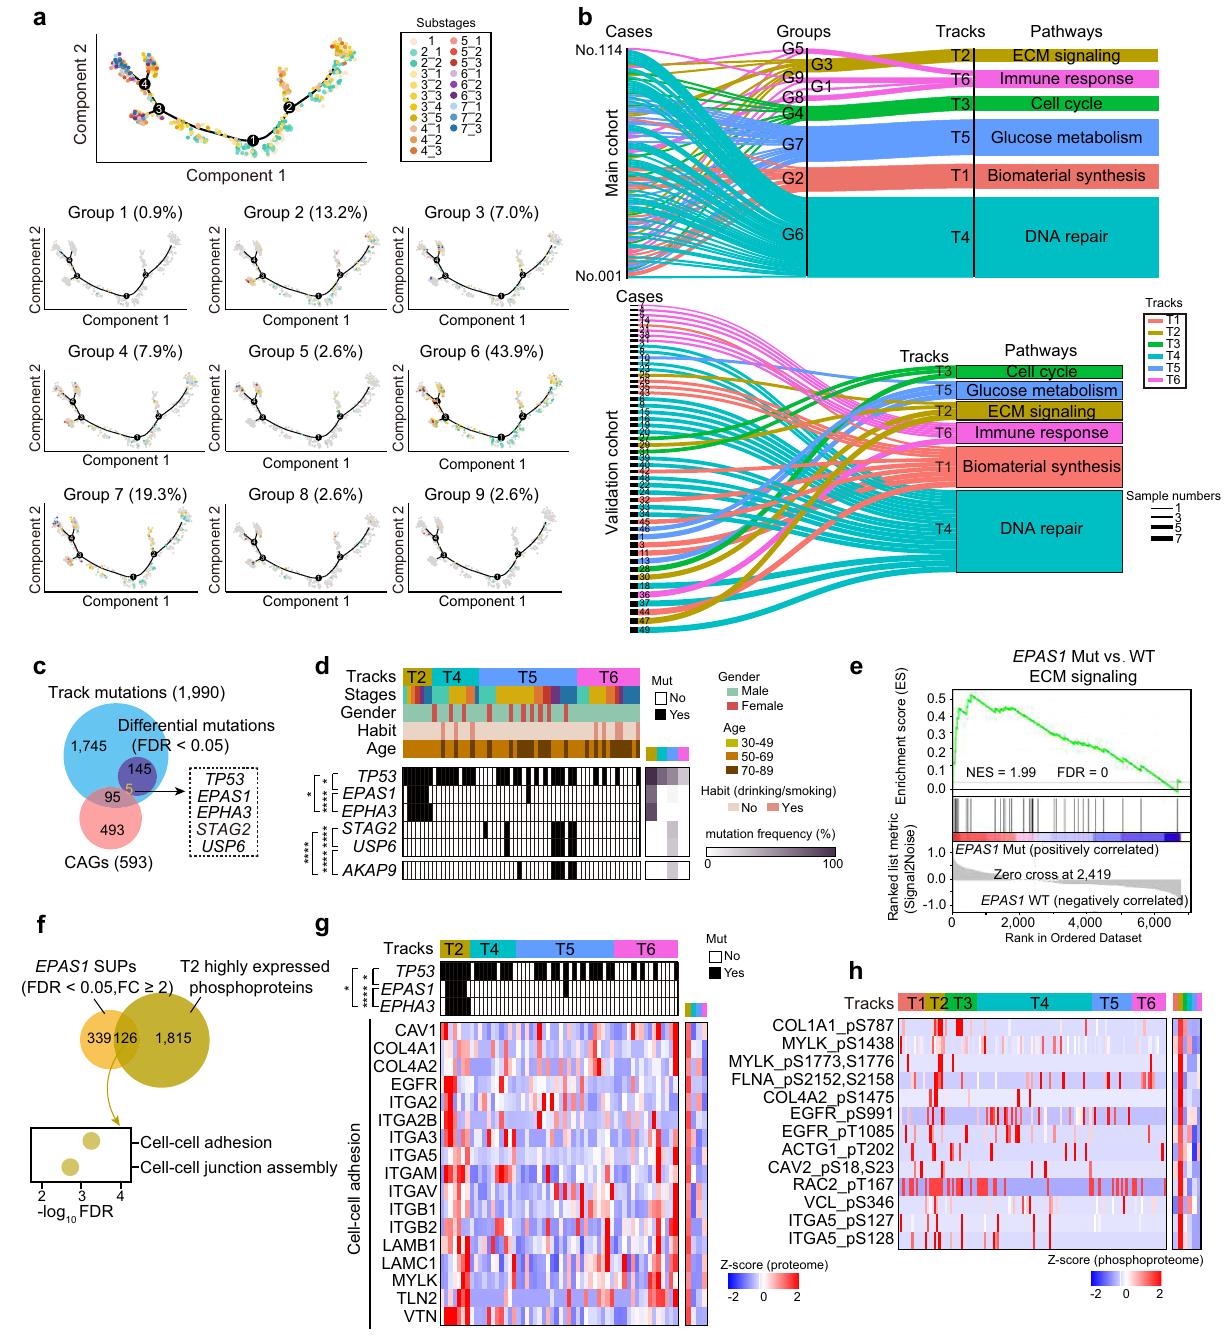
Fig. 6 | Personalized trajectory reveals six major carcinogenesis tracks of the early ESCCs. a The trajectory of 746 samples (top) and 114 early ESCC cases were grouped into 9 (bottom). b Sankey diagram analysis of 114 early ESCC cases (top, main cohort) and 49earlyESCCcases (bottom, validationcohort). c Venn diagram showingthetrackmutations(top)andtheCAGs(bottom)(two-sidedFisher ’ sexact test). CAGs: cancer-associated genes. The overlapped mutations are shown in the box. d The CAG-associated track mutations in the early ESCCs. The co-mutations are highlighted on the left (two-sided Fisher ’ s exact test), and the mutation fre- quency is shown on the right. The square directed to a subset of patient samples used for WES ( n =68) in early ESCCs. Co-mutations: * p =0.032 ( TP53 and EPAS1 ), * p =0.032 ( TP53 and EPHA3 ), **** p =9.3E – 6 ( EPAS1 and EPHA3 ), * p =2.2E – 7 ( STAG2 e GSEA plot (KEGG gene sets) for ECM signaling in EPAS1 mutation and WT